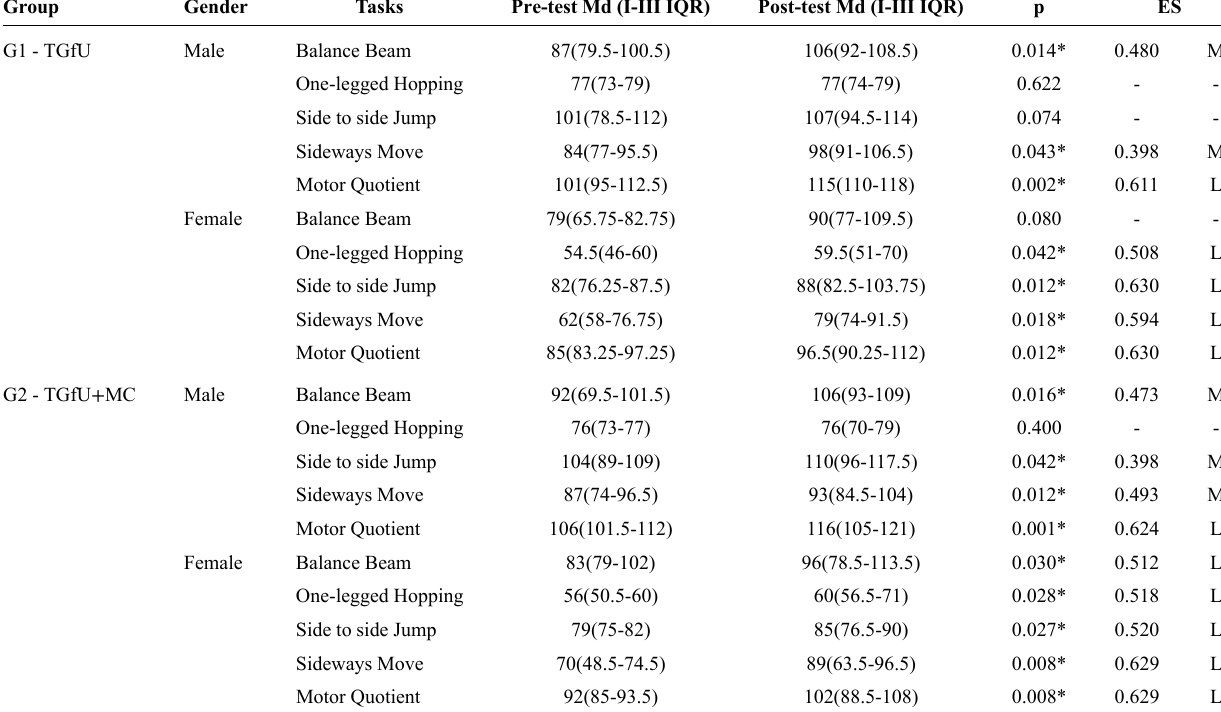
Table 1 - Median and interquartile ranges of the coordination test considering the effect time and gender in both groups.